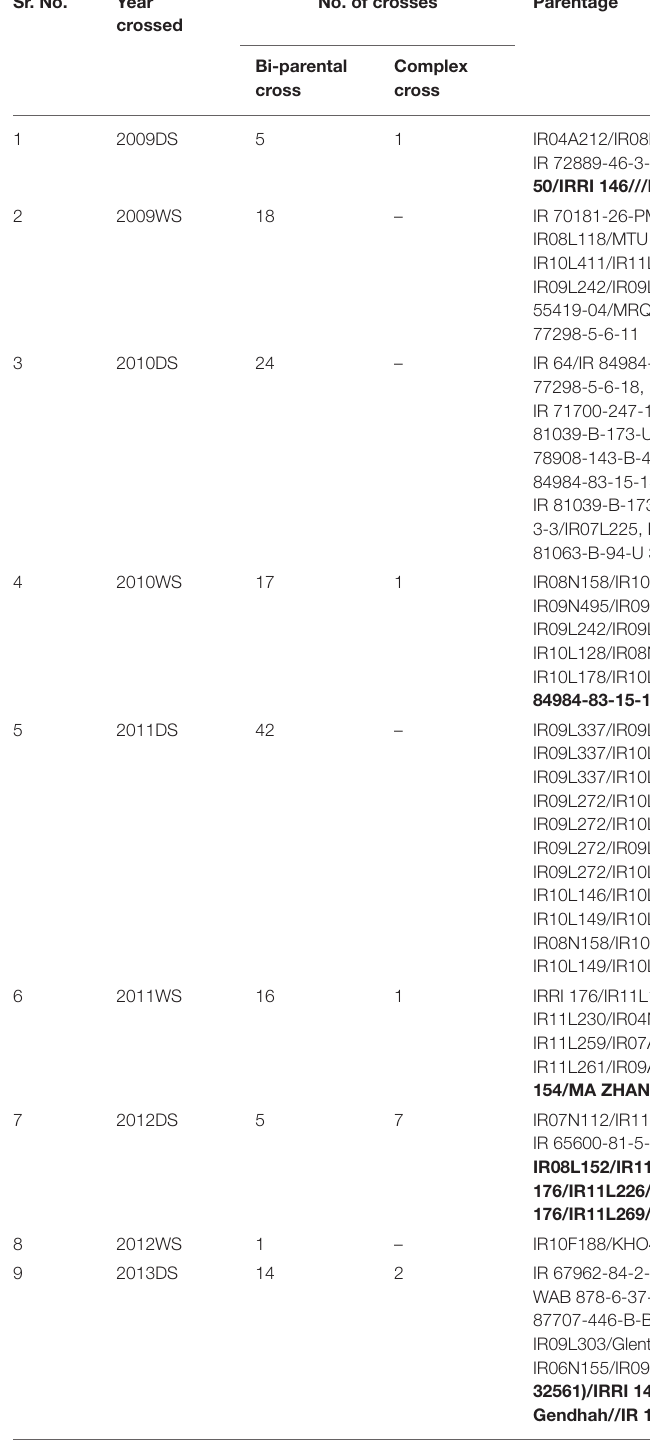
TABLE 1 | Detailed description on number of crosses developed per seasons/years and parentage to develop advanced breeding lines used in the present study. Sr.